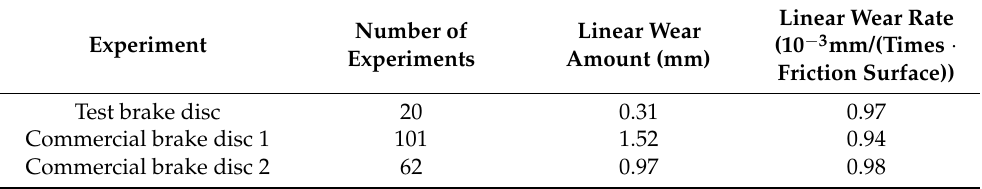
Table 7. Wear rates of the three brake discs at the design landing energy. Experiment